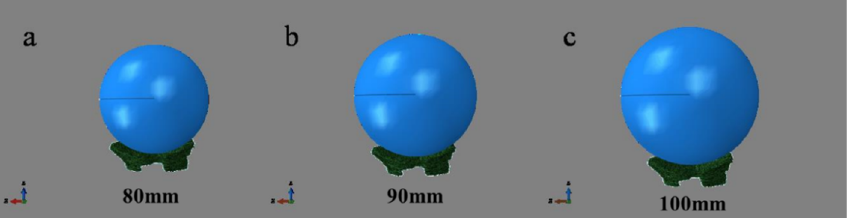
Figure 3. Assembly diagram of fetal head with different biparietal diameters and pelvic floor muscle.